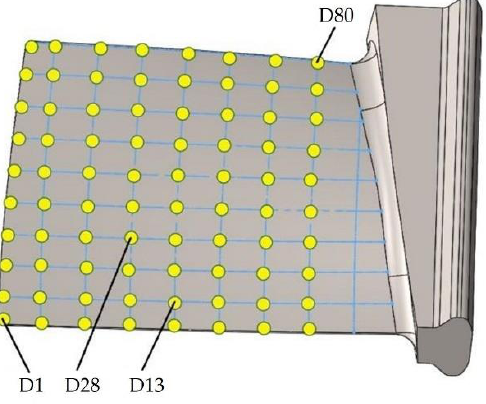
Figure 10. The back of the shoulder blade with a grid of points. In this way, the procedures performed for 80 points D1, D2,… D80, which were reg- istered in the script, were prepared shown in Figure 11.